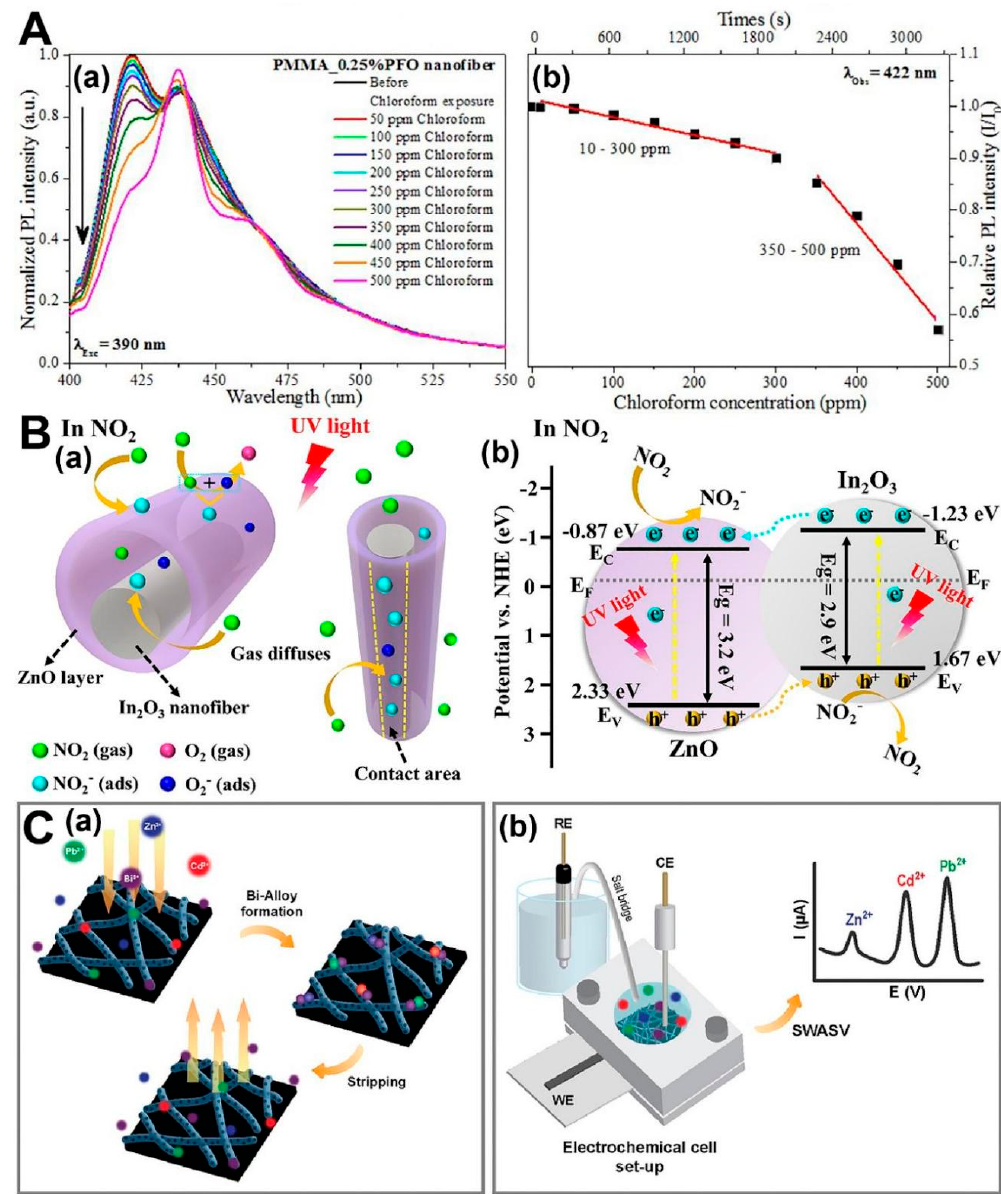
Figure 6. Electrospun-NFs-based chemosensors for gas pollutant. ( A ) PL spectra. ( a ) PMMA_0.25%PFO NF exposition to chloroform vapor; it was excited at 390 nm. ( b ) The dependence of the emission intensity as function of chloroform concentration for PMMA_0.25%PFO NF (monitored at 420 nm) (reproduced with permission from [178], copyright © 2017, Wiley Periodicals). ( B ) Schematic diagrams of ( a ) NO 2 detection process, ( b ) In 2 O 3 /ZnO heterojunctions, and cor- responding energy band diagram (reproduced with permission from [179], copyright © 2021, Elsevier). (C) The PE- DOT/PVA/AgNPs-fibers-modified SPCE preparation. ( a ) Bi-alloy formation on electrode surface, followed by stripping.